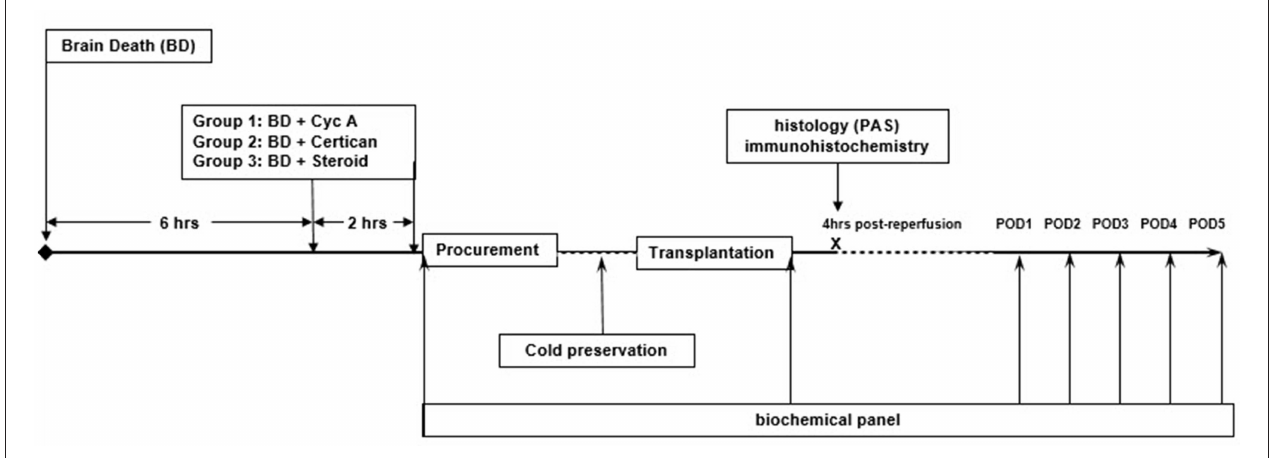
FIGURE 1 | Study design. Six hours after the induction of brain death, German landrace donor pigs (33.2 ± 3.9kg) were randomly preconditioned with either Cyclosporine ( n = 9) or Everolimus ( n = 9) administered via nasogastric tube with a repeated dose just before organ procurement. Control donors received intravenous (i.v.) Methylprednisolone ( n = 8). Kidneys were procured, cold-stored in HTK solution at 4 ◦ C and transplanted in nephrectomized recipients after a mean cold ischemia time of 19.32 ± 2.92 (SD) hours. No post-transplant immunosuppression was given to avoid confounding bias. Blood samples were obtained at 4h post reperfusion and daily until postoperative day (POD) 5 for complete blood count, blood urea nitrogen (BUN), creatinine (Cr), and electrolytes. Graft protocol biopsies were performed 4h after reperfusion to assess early histological and immunohistochemical changes.